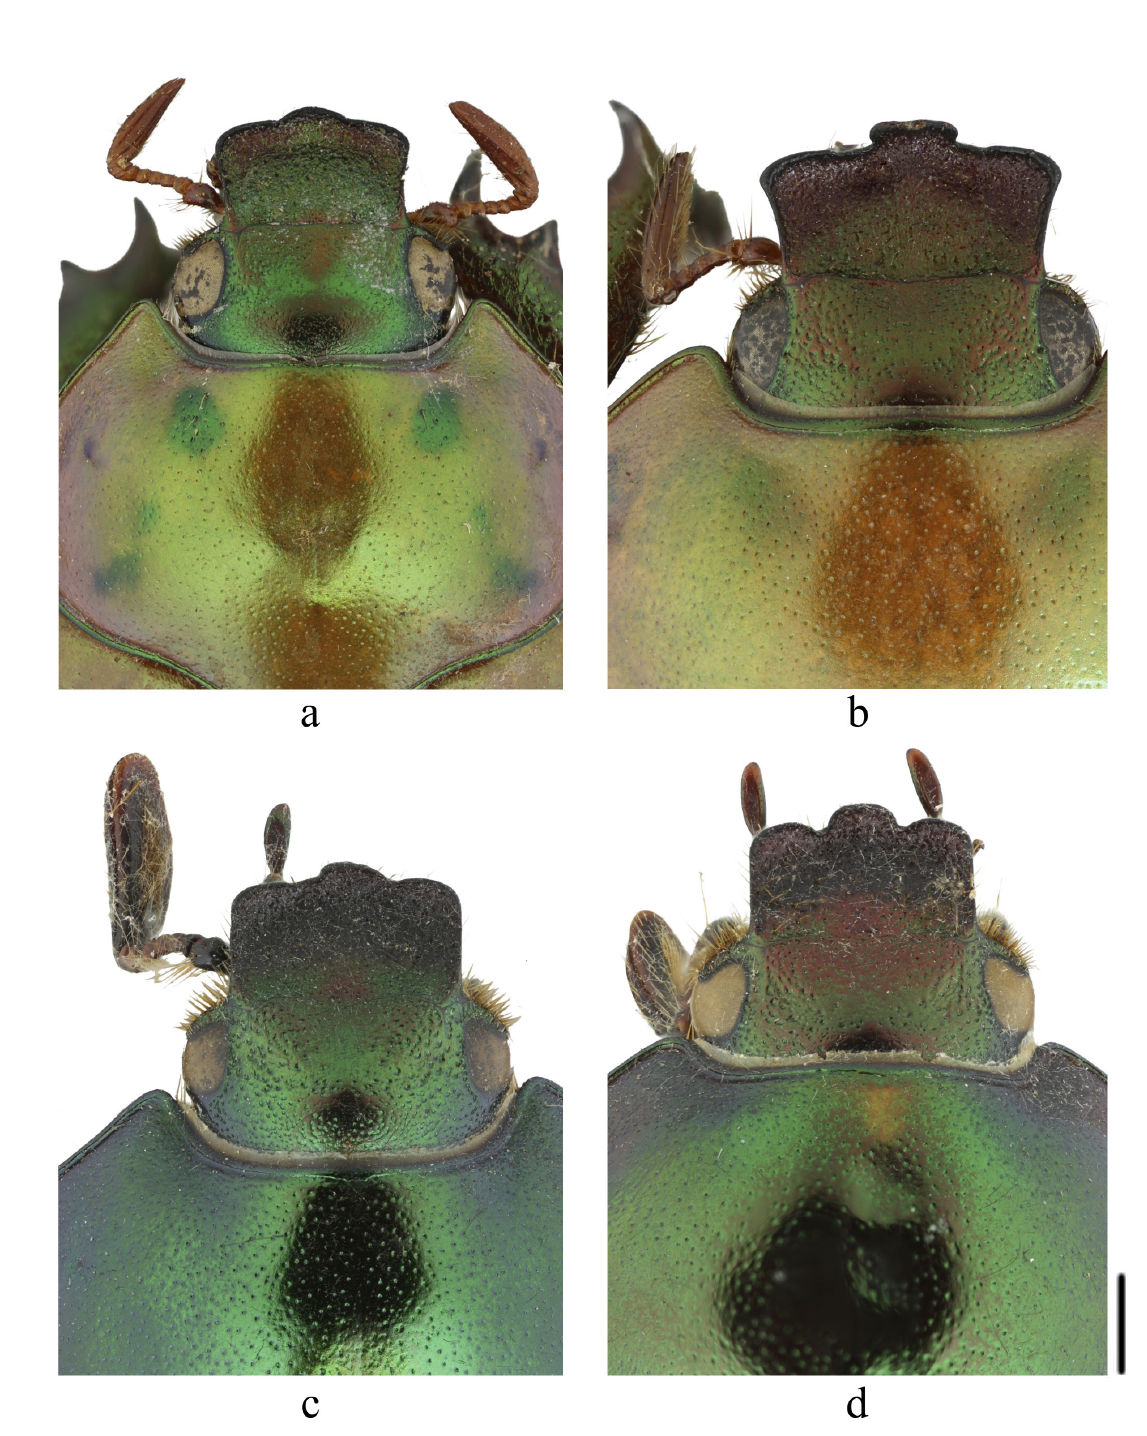
Fig. 3. Head and pronotum details. a . Oplognathus kirbii MacLeay, 1819, male specimen (ZMHB). b . O. bahianus Ohaus, 1912, syntype, ♂ (ZMHB). c . O. helmenreichi Ohaus, 1905, holotype, ♂